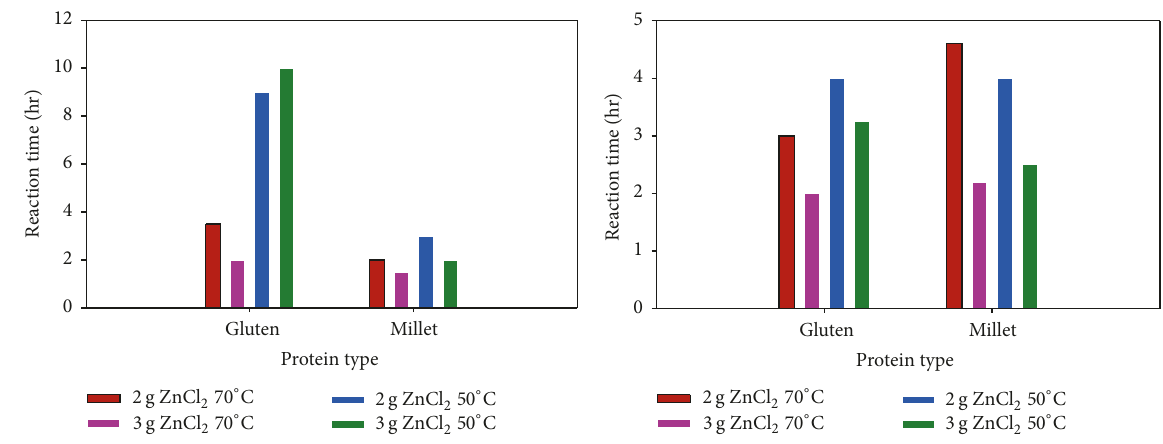
(b) Reaction time of gluten and millet proteins interaction with sun- flower oil epoxy as a function of zinc chloride